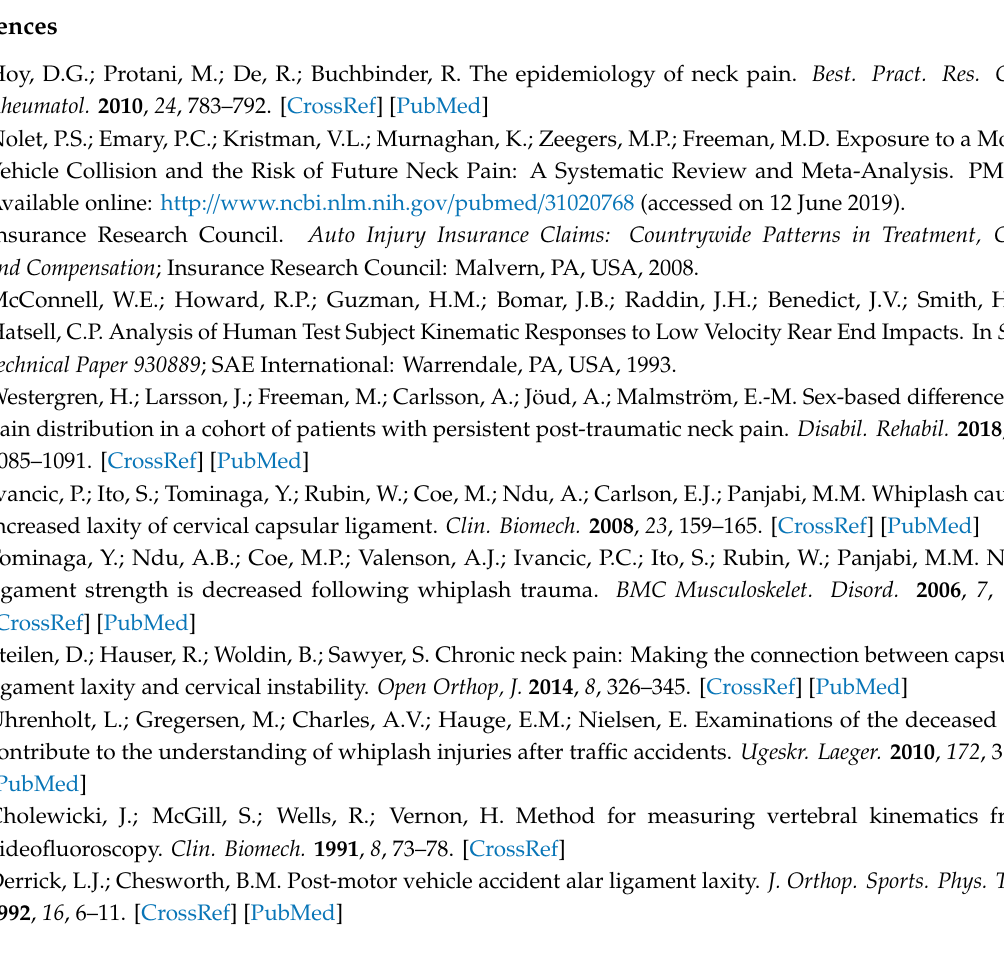
Table S1: DMX paper analysis data set, Table S2: STARD-2015-Checklist VF